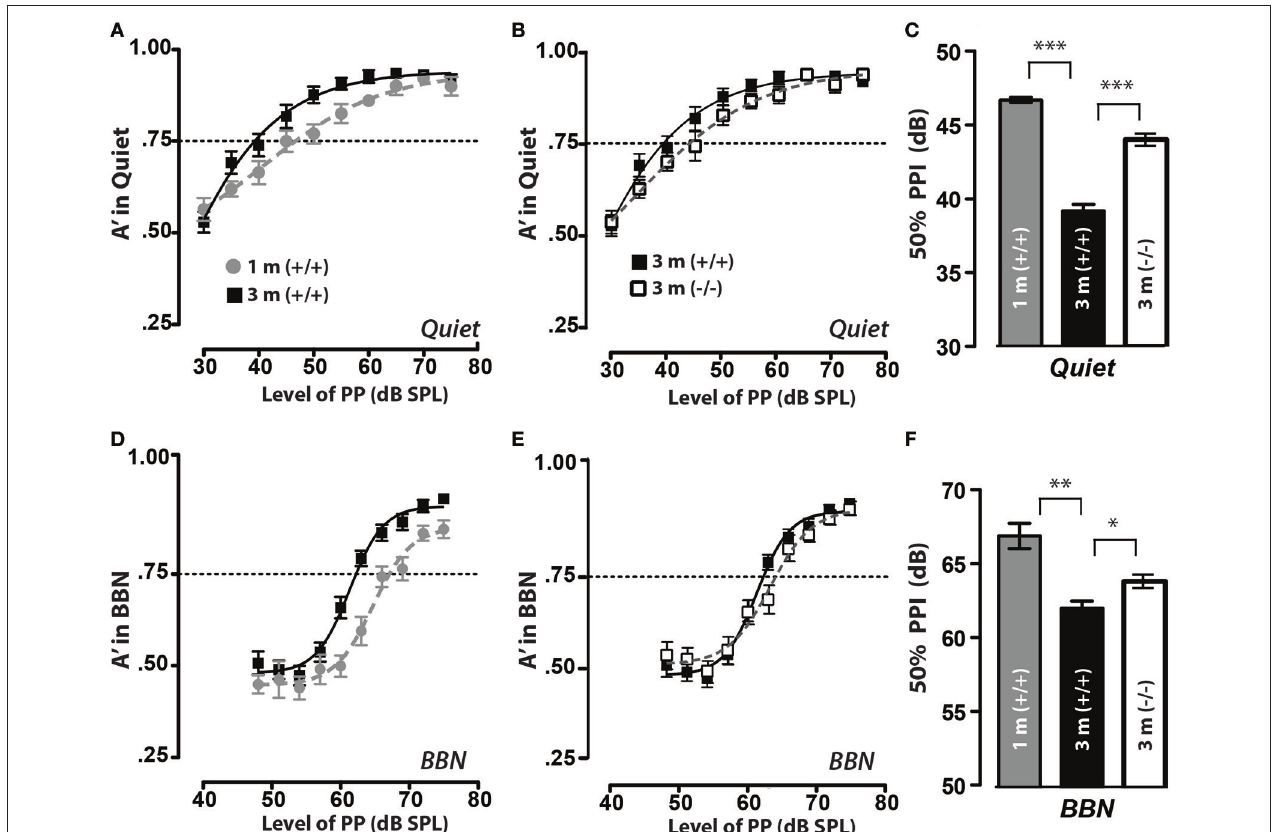
FIGURE 4 | Prepulse inhibition improves during juvenile to adult maturation with the LOC neuropeptide CGRP. (A) In quiet, CGRP ( + / + ) animals of both ages can inhibit their acoustic startle with a prepulse at 80 dB, and did not inhibit their startle with a prepulse at 30 dB (edges of psychometric function). However, the threshold for inhibiting their startle response 50% of presentations (A ′ = 0.75) is higher at 1 month (1m) and drops by 3m of age. (B) Similarly, in quiet, CGRP (–/–) animals can inhibit their acoustic startle yet the threshold for inhibiting their startle response 50% of the time (A ′ = 0.75) is higher at for CGRP null (–/–) animals when compared to CGRP wildtype control ( + / + ) animals tested at 3 months of age. (C) Mean PPI thresholds (defined as prepulse level at A ′ = 0.75) and SEM values are shown for both CGRP ( + / + ) solid bars and CGRP null (–/–) animals (open bars), and each group contained 12 mice. There was a significant threshold increase for CGRP ( + / + ) animals between 1 and 3m (*** p < 0.001). (D,E) When prepulse inhibition of the acoustic startle reflex was tested in 60 dB background noise (BBN), CGRP ( + / + ) and CGRP (–/–) mice of both ages were able to inhibit their startle reflex when tested with a prepulse of 80 dB, but did not inhibit their startle with a prepulse at 50 dB; yet similar to the quiet condition, the threshold for 1 month animals was higher than for the same animals at 3m. (F) There was a significant decrease in PPI thresholds in BBN in CGRP ( + / + ) between 1 and 3m (** p < 0.01), and a less significant increase in PPI thresholds in CGRP null (–/–) animal’s thresholds with maturation (* p <